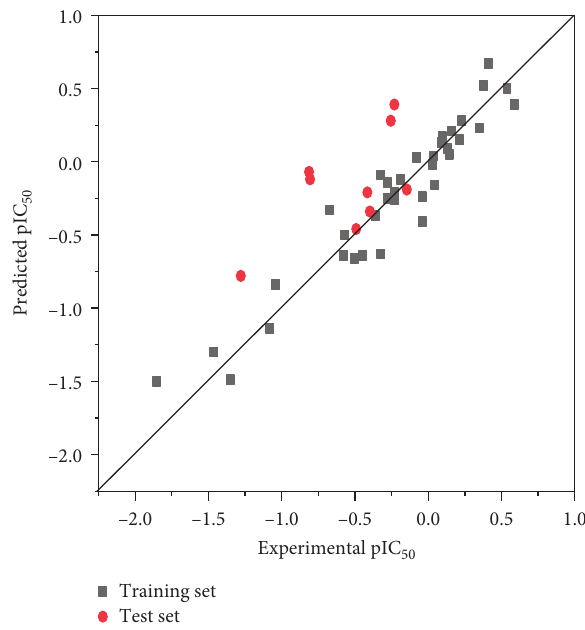
Figure 2: Experimental versus predicted anti-LOX potency. The training and the test set are displayed in squared (black) and circled (red) points,